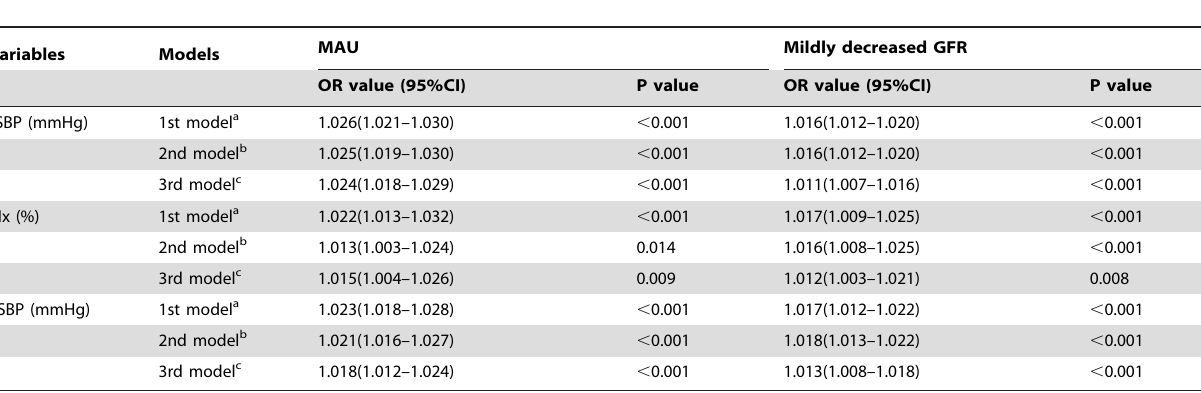
Table 4. Independent association of MAU and mildly decreased GFR with AIx and BP according to multivariate